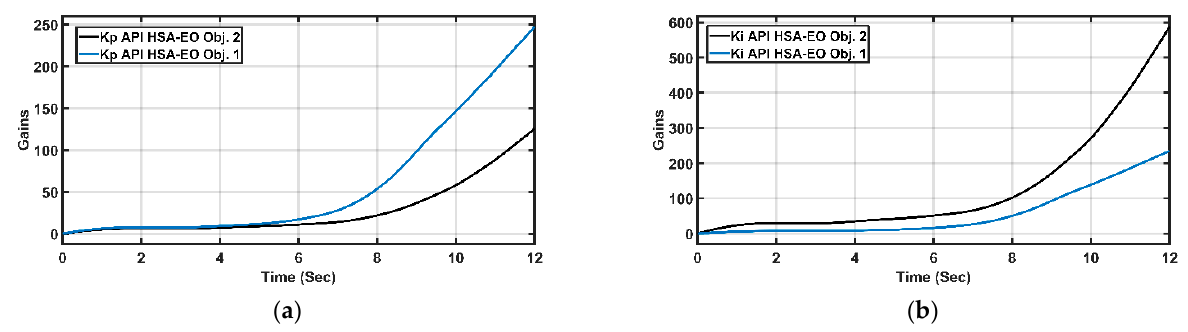
Figure 29. ( a ) Active power responses of faulty second case. ( b ) Blade-angle responses of faulty second case.